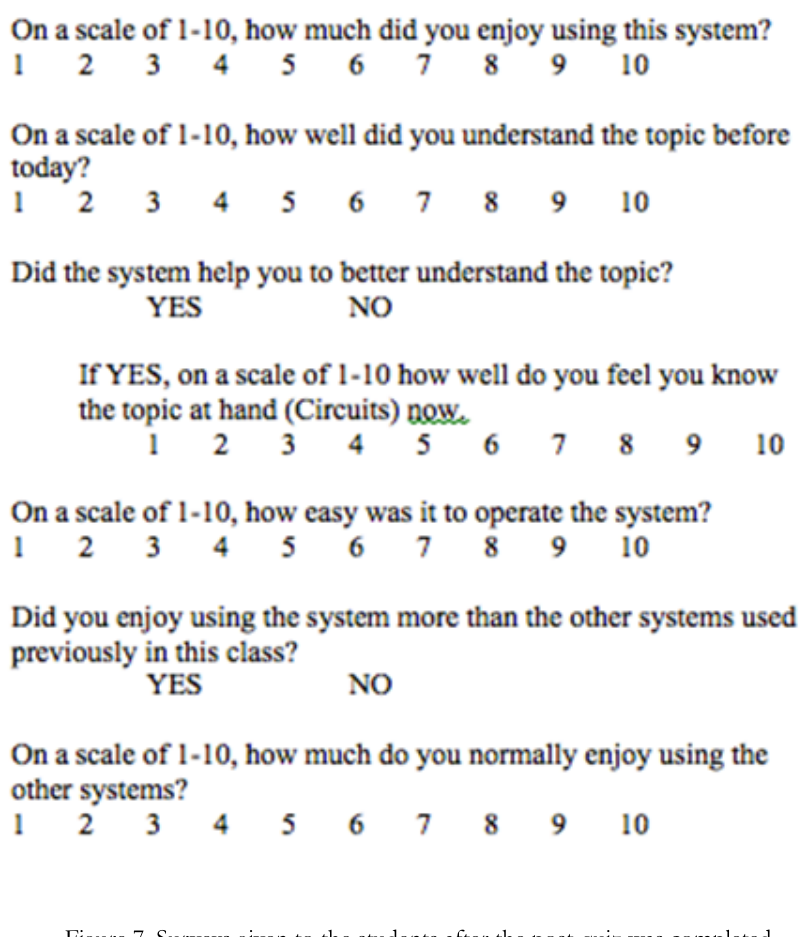
Figure 7. Surveys given to the students after the post-quiz was